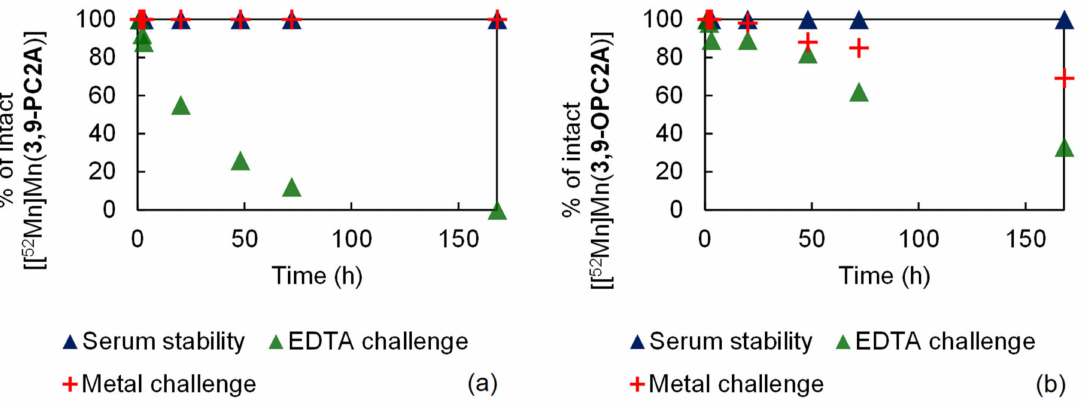
Figure 7. Results of the stability tests of [[ 52 Mn]Mn( 3,9-PC2A )] ( a ) and [[ 52 M]Mn( 3,9-OPC2A )] ( b